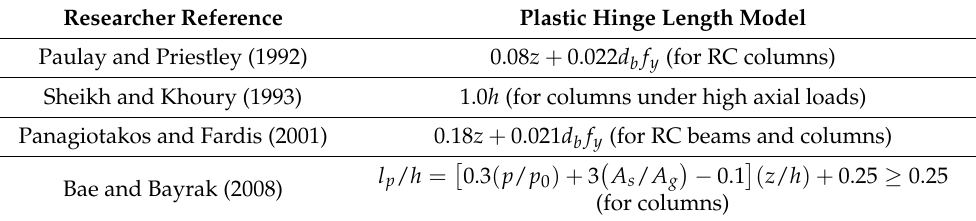
Table 3. Previous studies of plastic hinge length for RC